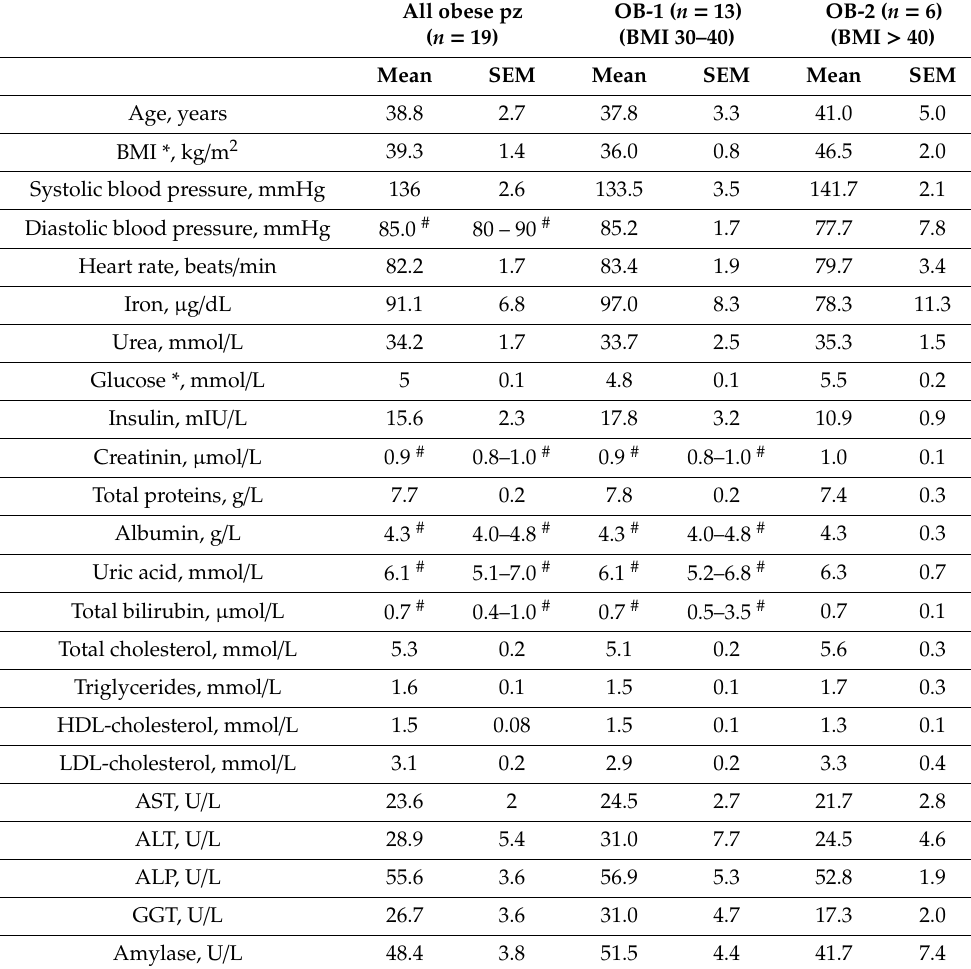
Table 1. Clinical and biochemical characteristics of obese